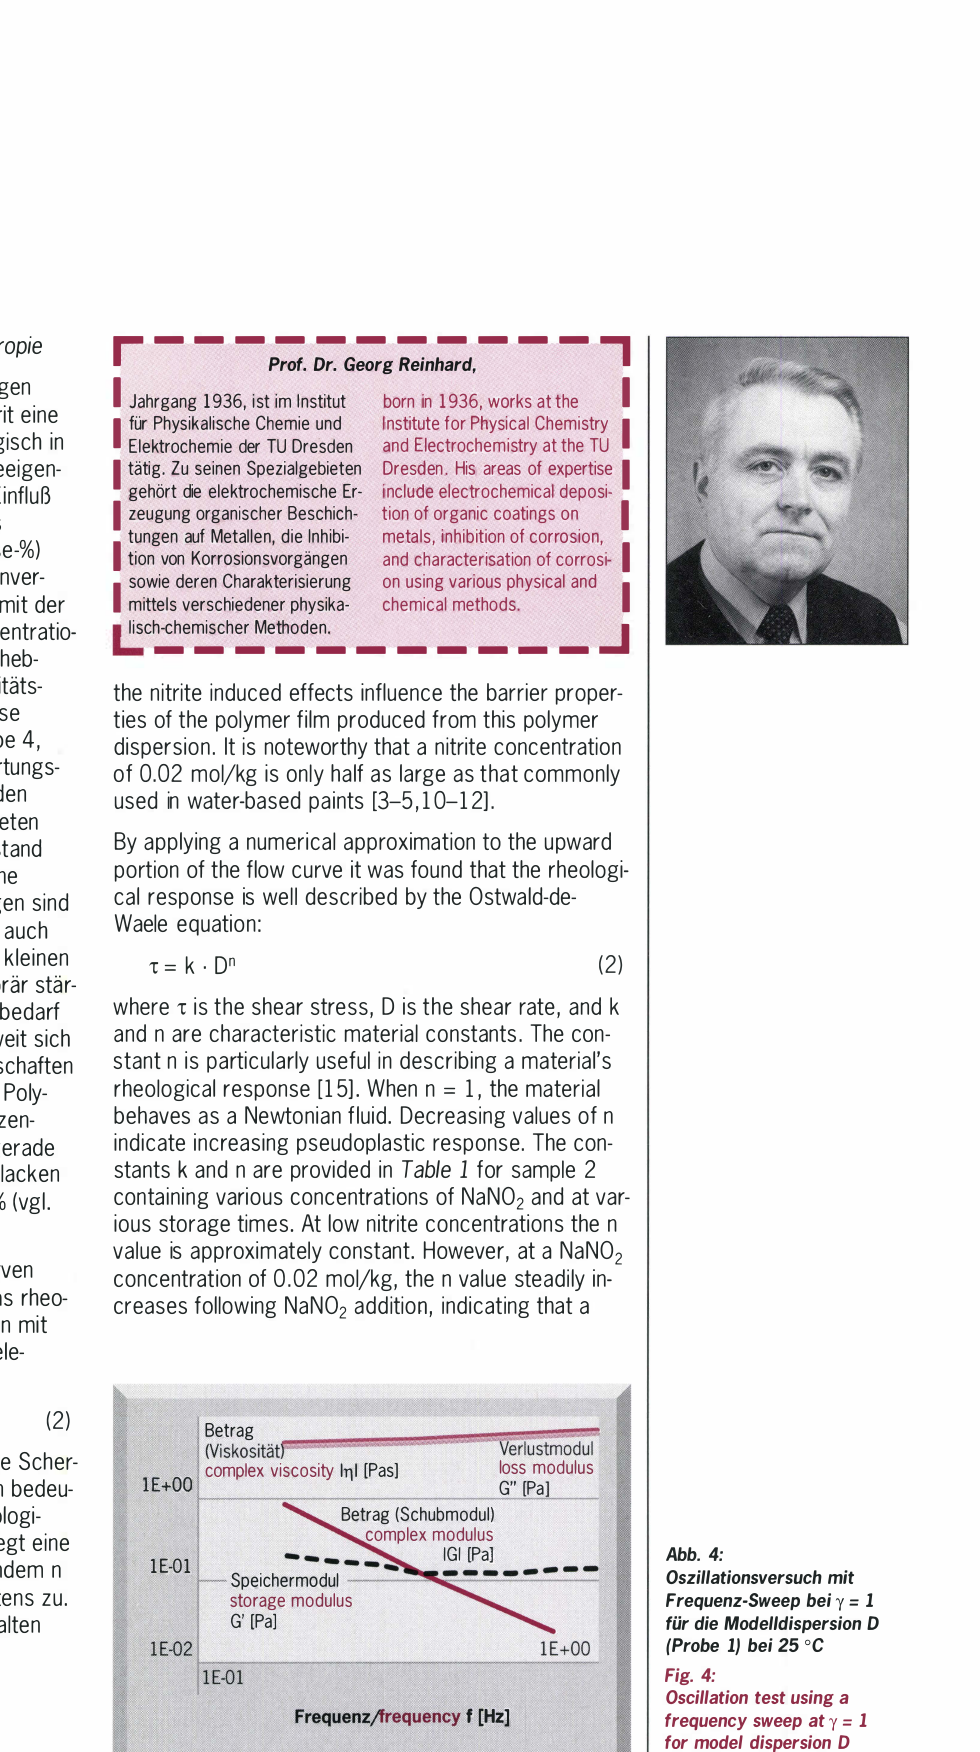
Fig. 4: Oscillation test using a frequency sweep at y = 1 for model dispersion D (sample 1} at 25 o